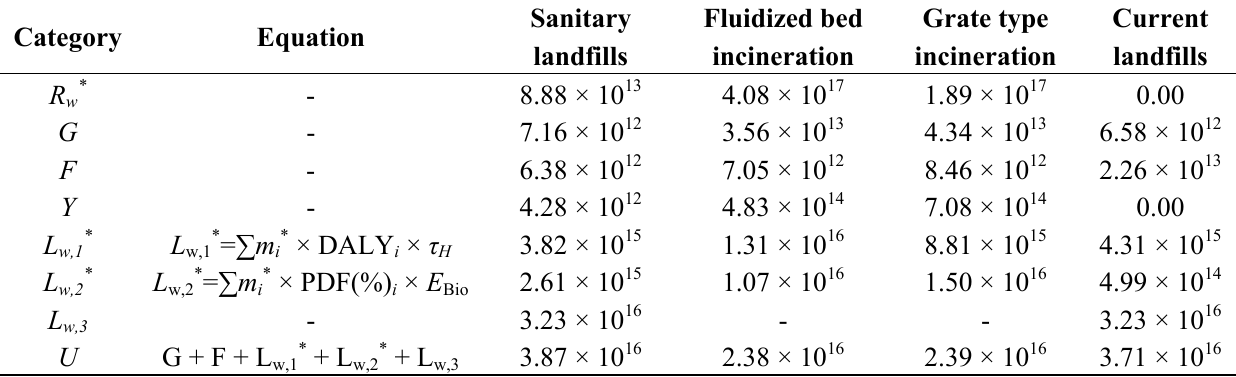
Table 7. The values of the four waste disposal methods’ emergy based indicators (Unit: